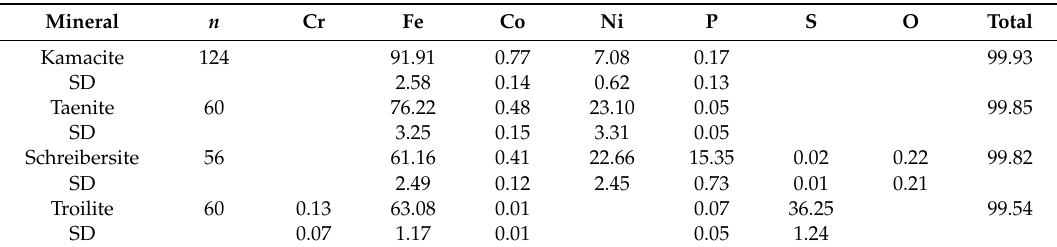
Table 1. Average composition (wt.%) of primary minerals from the Elga meteorite.